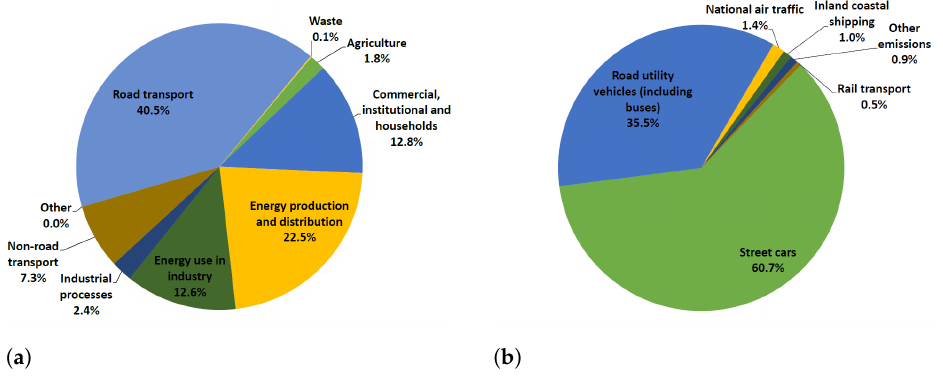
Figure 1. Main sources of NO 2 emissions of nitrogen oxides. ( a ) Contribution made by different sectors to emissions of nitrogen oxides in 2011. ( b ) Different emission sources in traffic 2017,